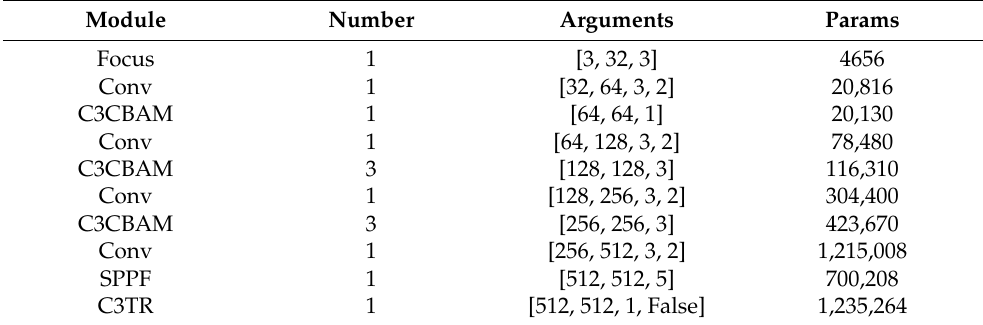
Table 2. Improved Backbone network structure.